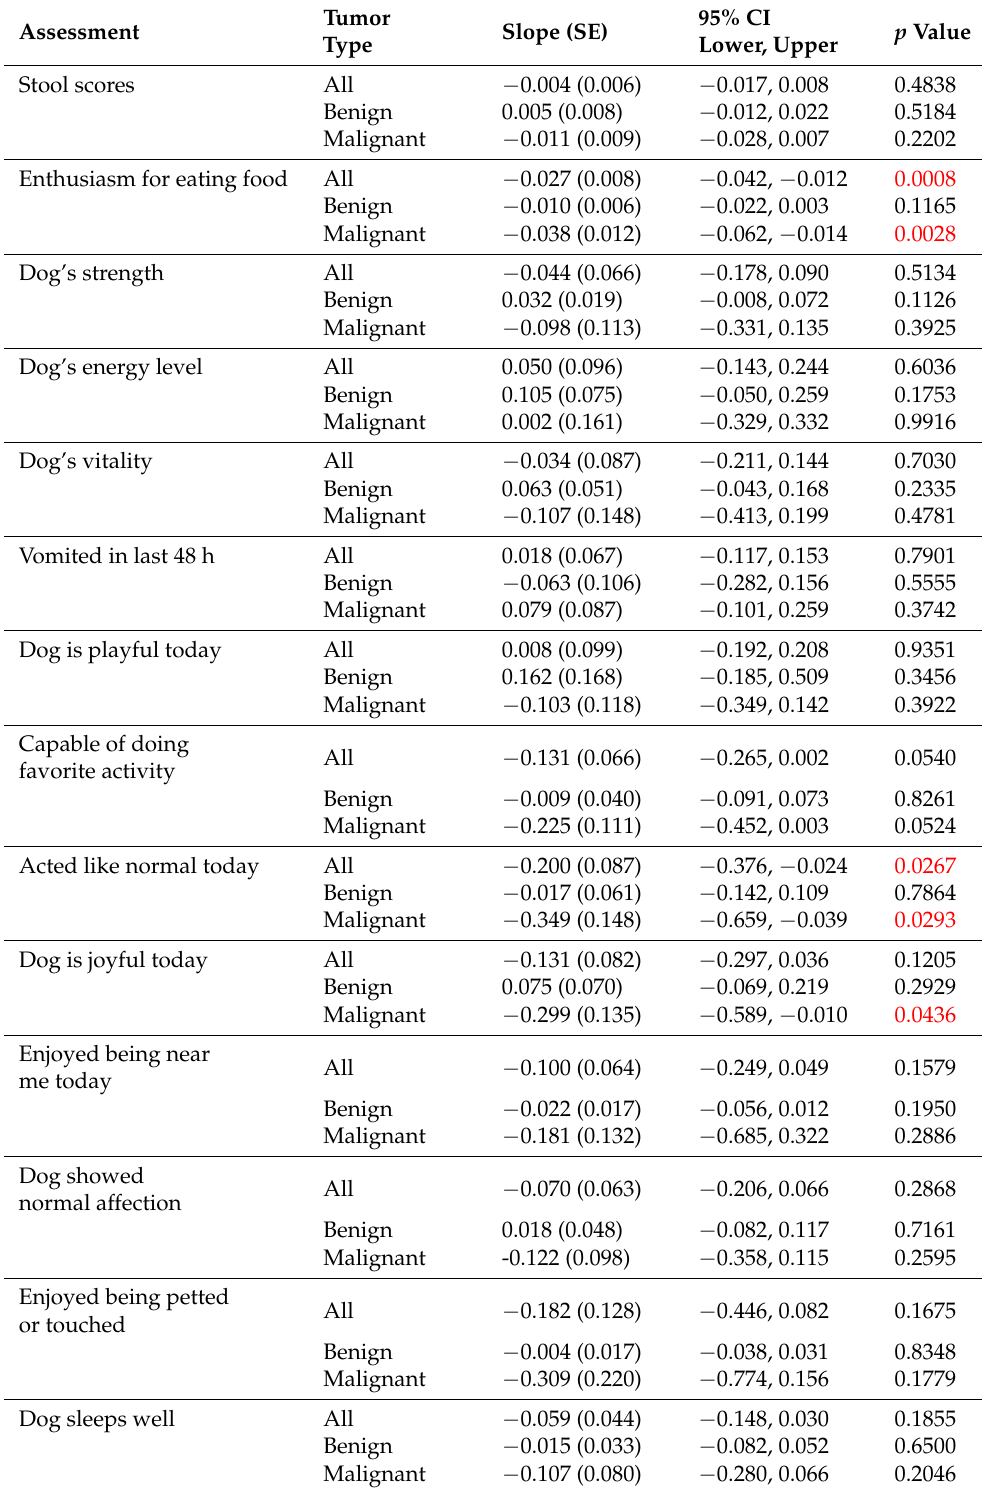
Table 4. Differences from enrollment in owner-reported outcomes of food evaluation and quality of life. The p values in red indicate whether the slope is significantly different from